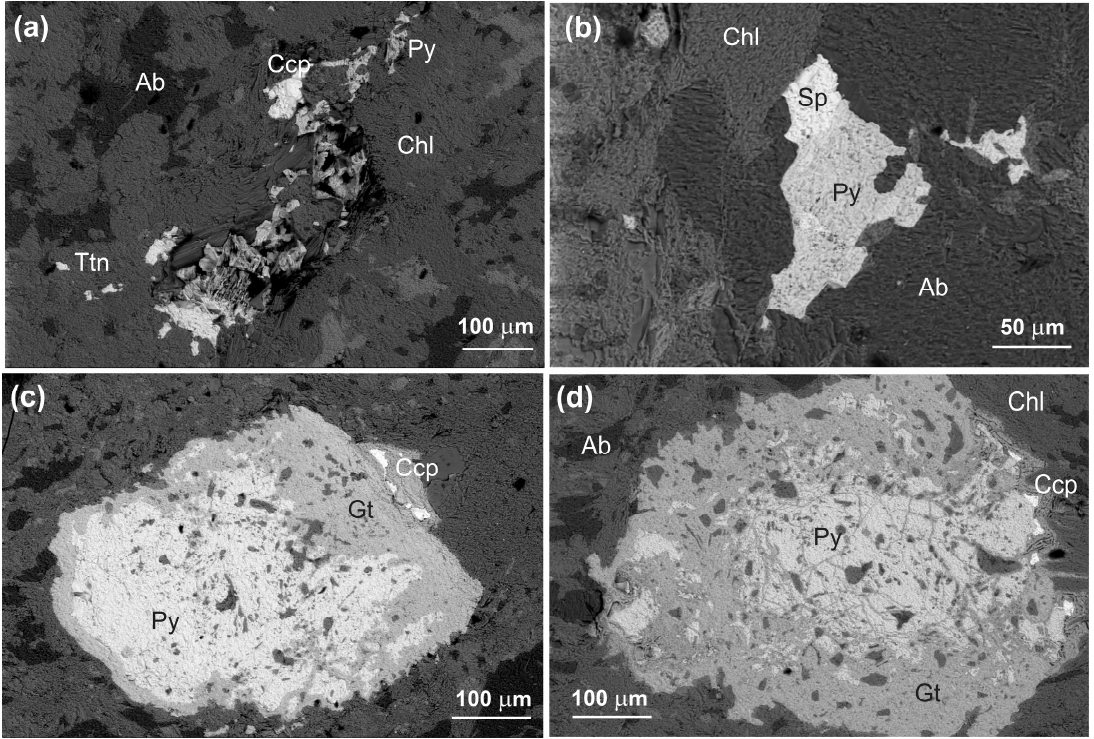
Figure 19. Microstructures in ore samples from Val Perossa (Brg1822). SEM-BSE images. ( a ) Pyrite (Py, grey), chalcopyrite (Ccp), titanite (bright spots on lower left, Ttn) and albite (Ab, black) in a matrix of chlorite (Chl); ( b ) Pyrite (Py) with sphalerite (Sp). ( c , d ) Pyrite (Py) altered to goethite (Gt) with regions of chalcopyrite (Ccp, bright spots on right side).